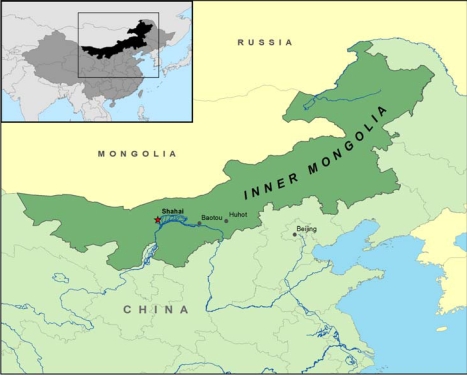
Study site and vicinity.